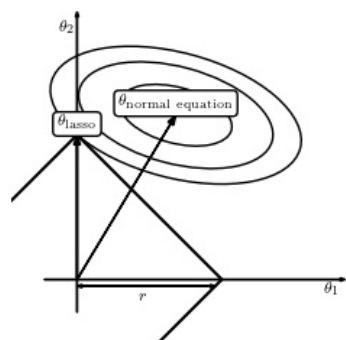
Figure 1. Visualization of the effect of L 1 regularization: solution provided by lasso φ lasso versus the unconstrained (regular) solution φ normalequation